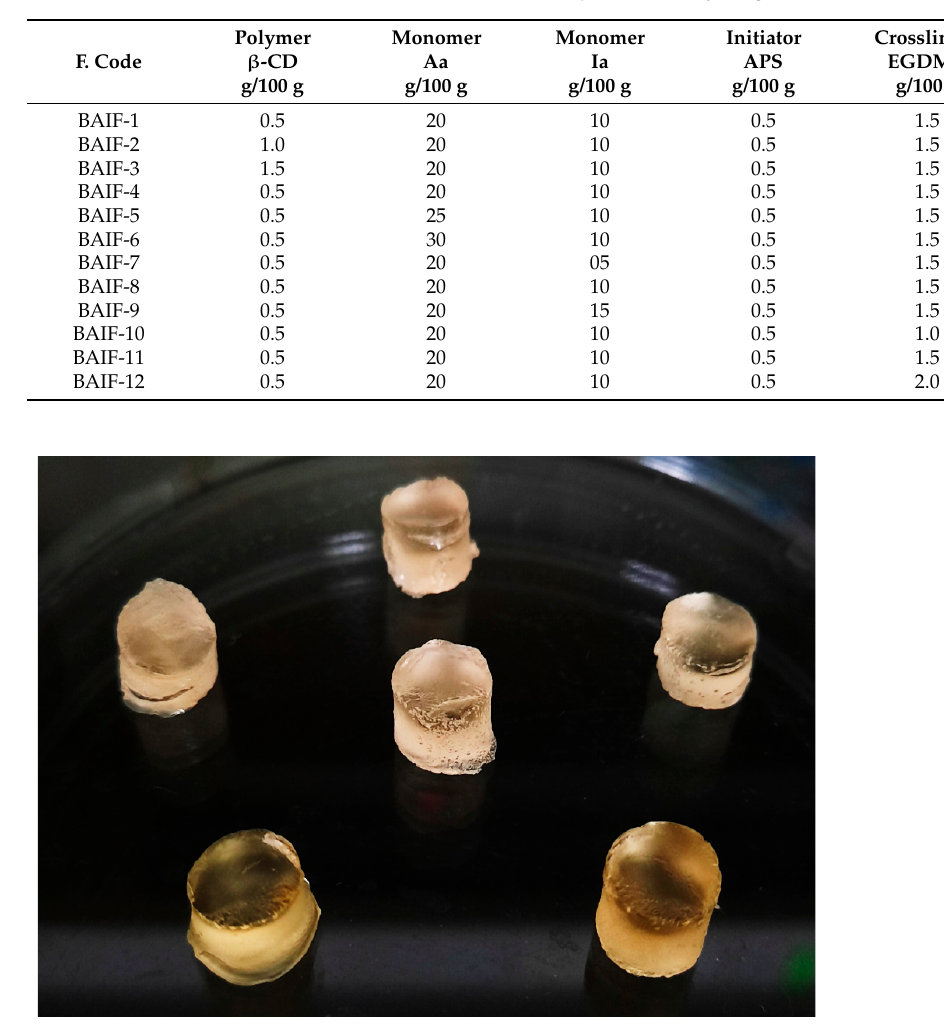
Figure 1. Physical appearance of prepared β -CD- g -P(Aa/Ia)